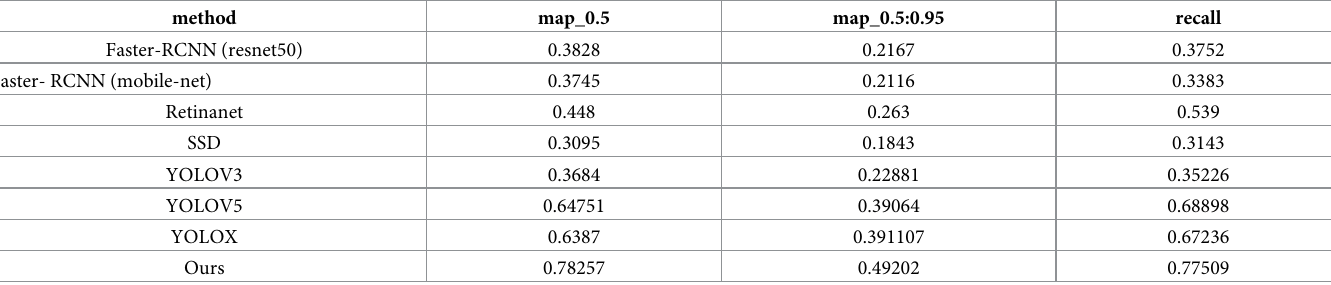
Table 1. Comparison of the proposed method with Faster- RCNN, Retinanet, SSD, YOLOV3, YOLOV5, and YOLOX on the same dataset for each metric.